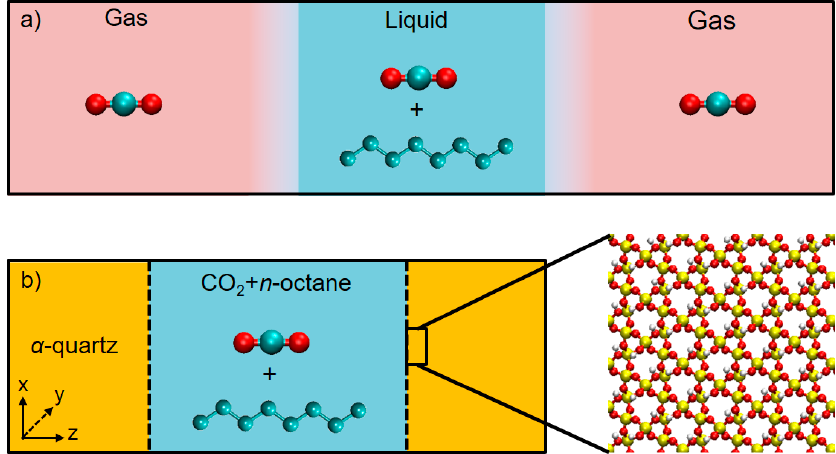
Figure 1. The schematic configuration of the simulation unit cell. ( a ) CO 2 and n -octane binary system. ( b ) CO 2 and n -octane in α -quartz nanoslit. Atom color codes: H, white; Si, yellow; O, red; C, CH 2 ; and CH 3 , cyan.